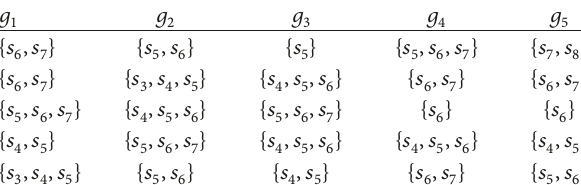
Table 5: Normalize information matrix 𝐻